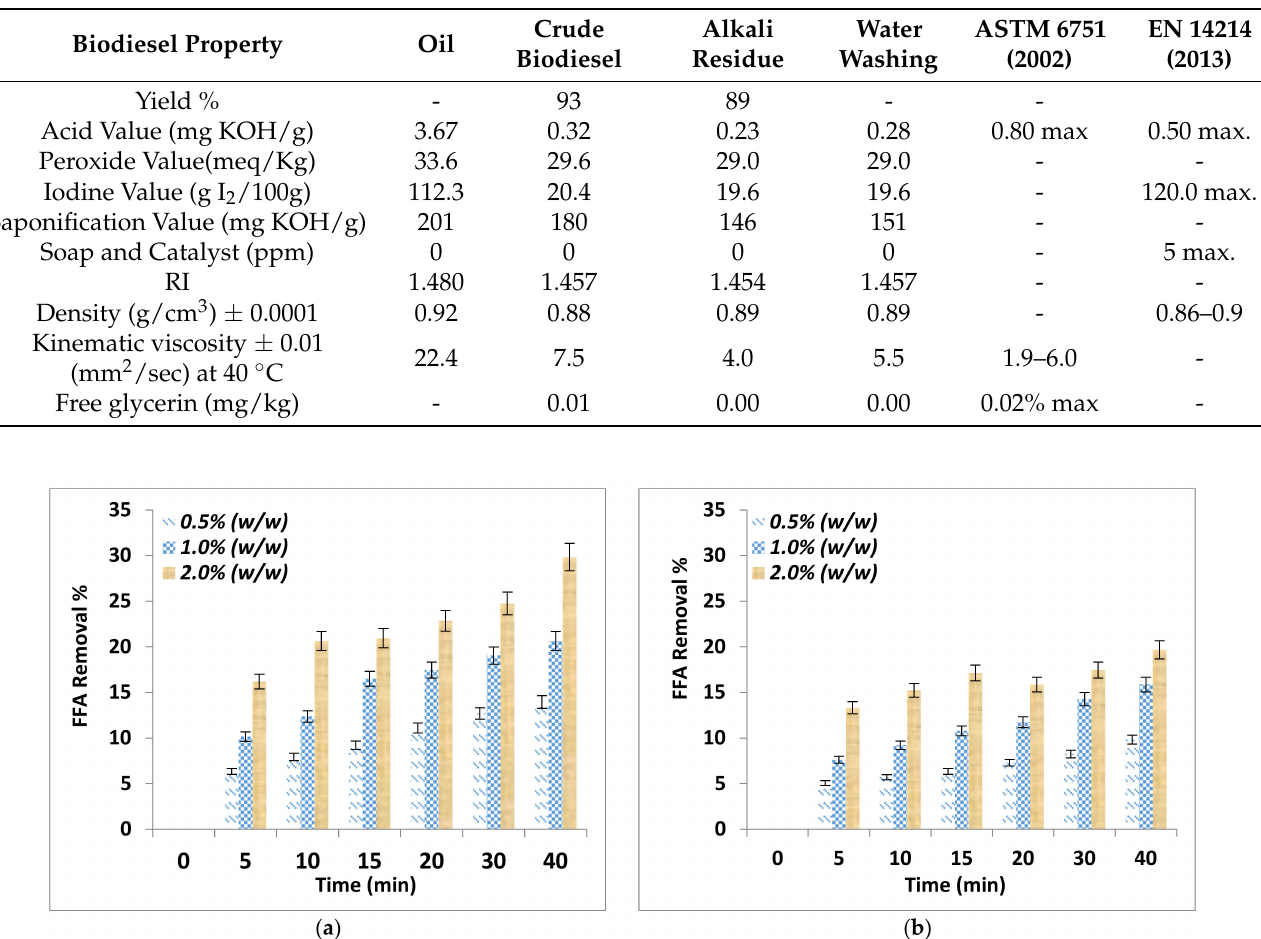
Figure 1. FFA removal as a function of adsorption time for various adsorbent dosage ( a ) Particle sizes ≤ 90 µ m ( b ) Particle size of ≤ 150 µ m.